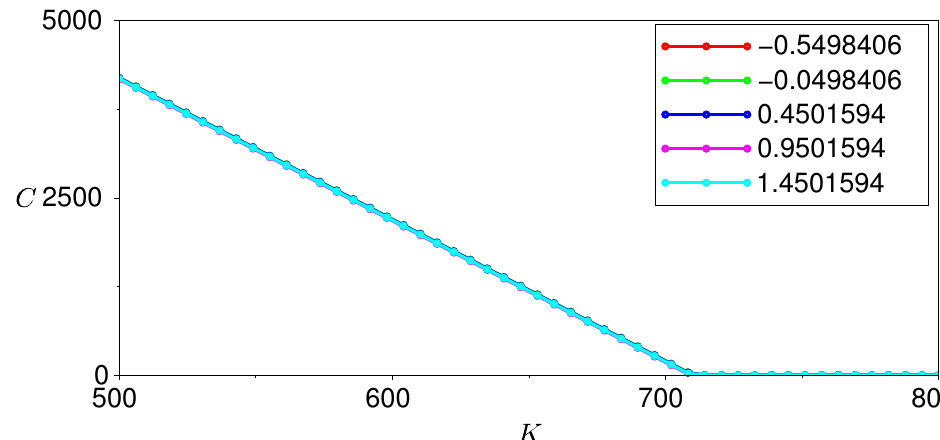
Figure 11. Option prices for varying values of σ 1 .